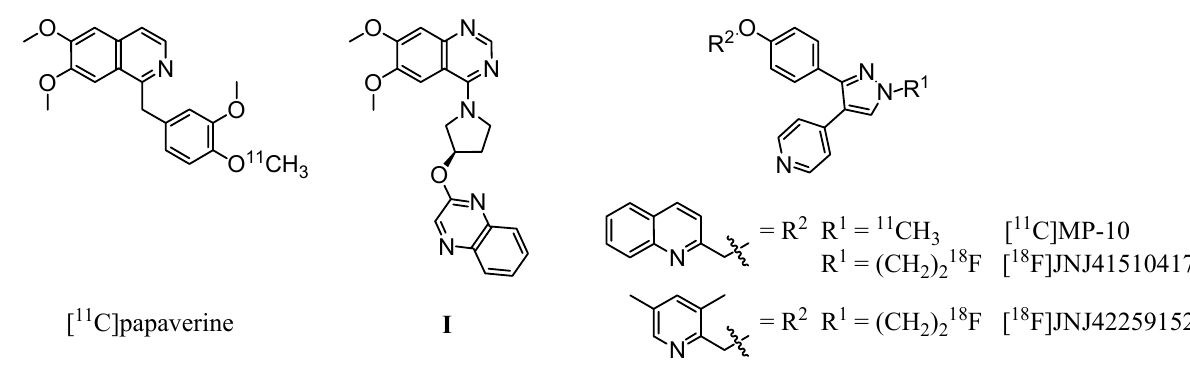
Figure 1. Radioligands investigated for PDE10A imaging and compound I , used as lead structure in this